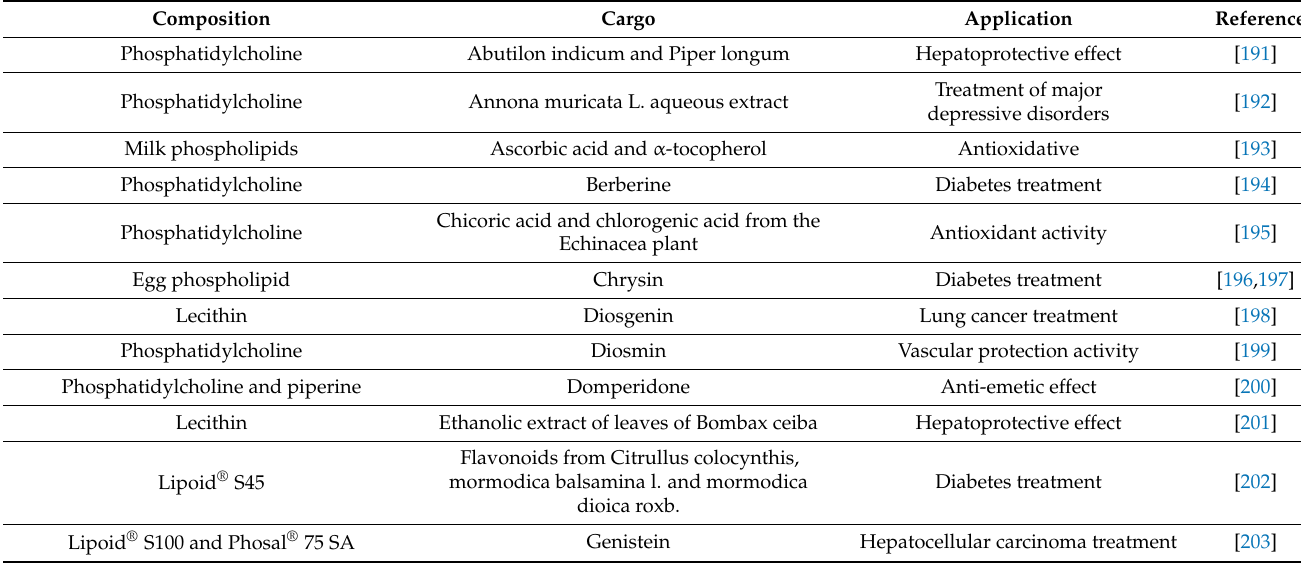
Table 7. Phytosomes’ drug delivery